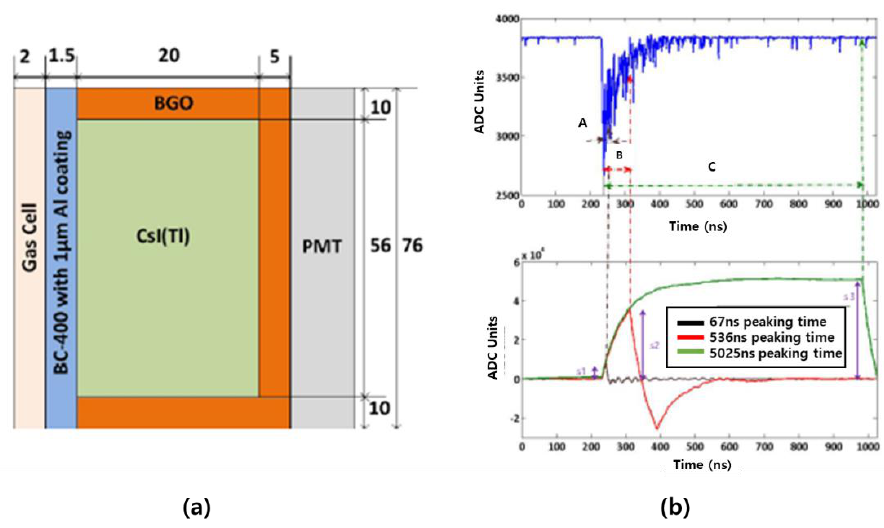
Figure 23. Phoswich detector ( a ) developed by Oregon State University and the filter signal for